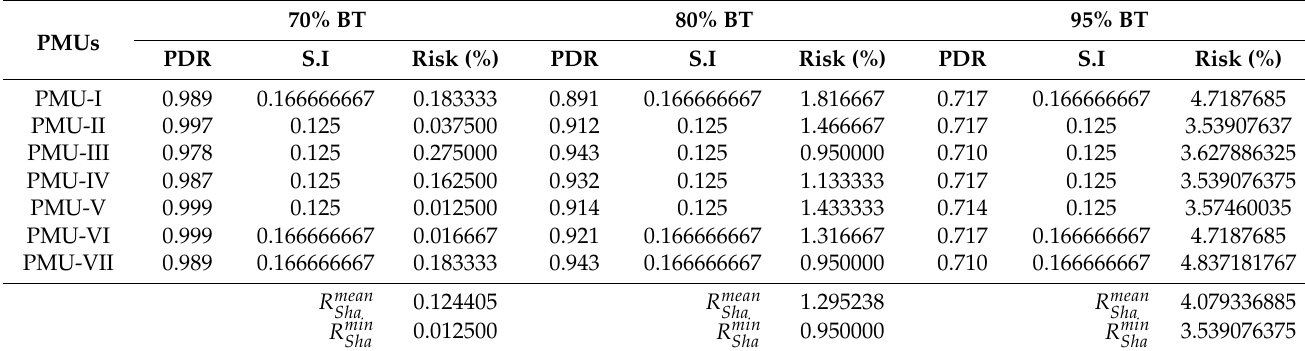
Table 4. Simulation results of shared SCN with 64 Kbps data rate under varying BT.